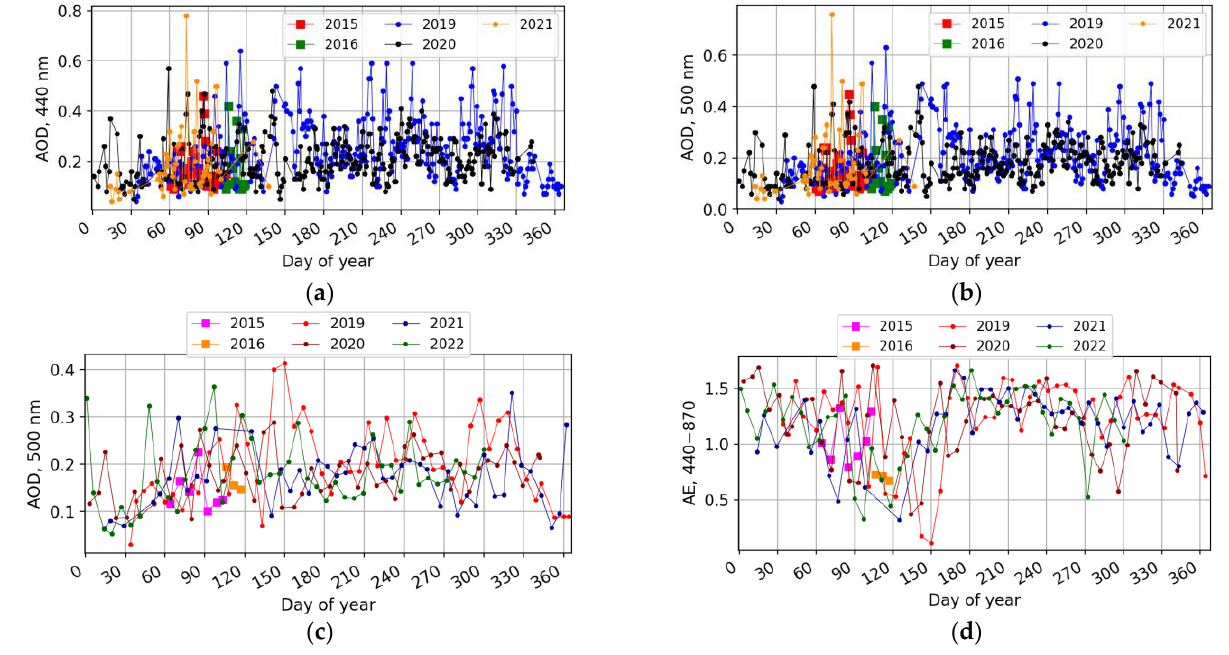
Figure 2. Aerosol optical depth and Ångström exponent during the 2015–2022 period; ( a ) AOD (440 nm) and ( b ) AOD (500 nm) daily mean data; ( c ) AOD (500 nm) and ( d ) AE (440–870 nm) weekly mean data. The AERONET sun-photometer data ( a , b ) level 2.0 (2015–2021) and level 1.5 (2021–2022); see details in the text. Data in ( c , d ) level 2.0 (2015 – 2019) and level 1.5 (2020 – 2022).